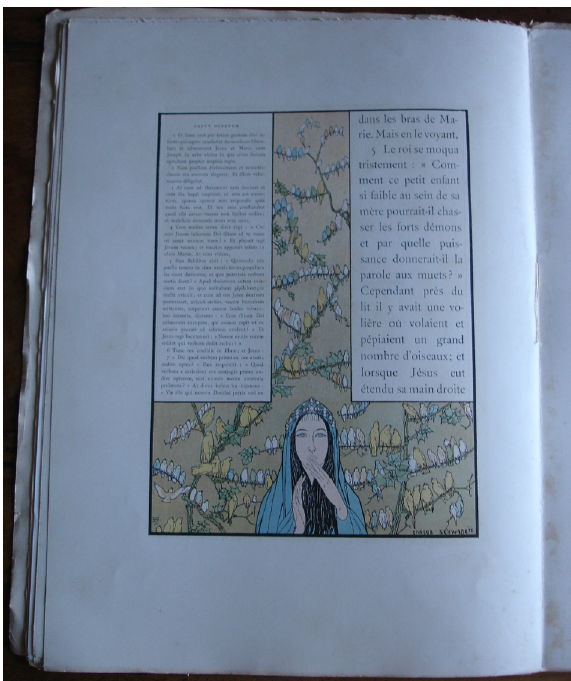
Fig. 4 Revue illustrée , no. 161 (15 August 1895), L’Évangile de l’Enfance de Notre Seigneur Jésus-Christ selon saint Pierre , illustrated by Carloz Schwabe, page in gathering no. 6 with both Latin original and translation into French. Private